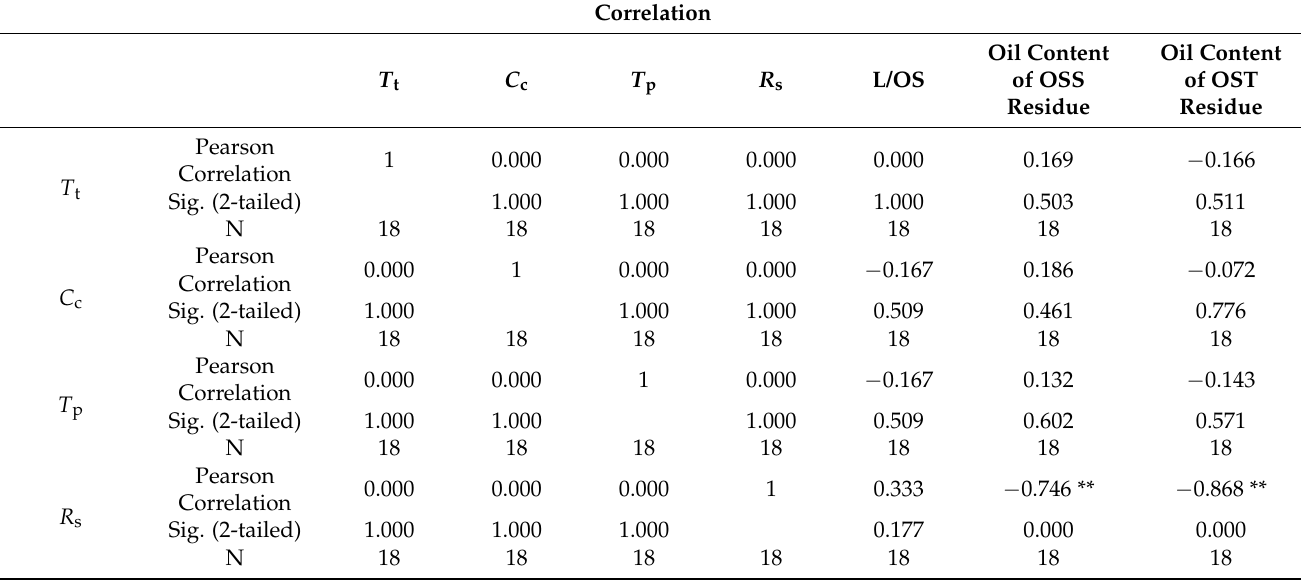
Table 6. Results of statistical product and service solutions correlation